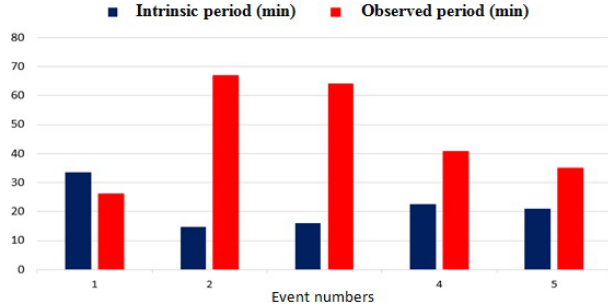
Figure 3. Bar chart of the intrinsic and observed periods.